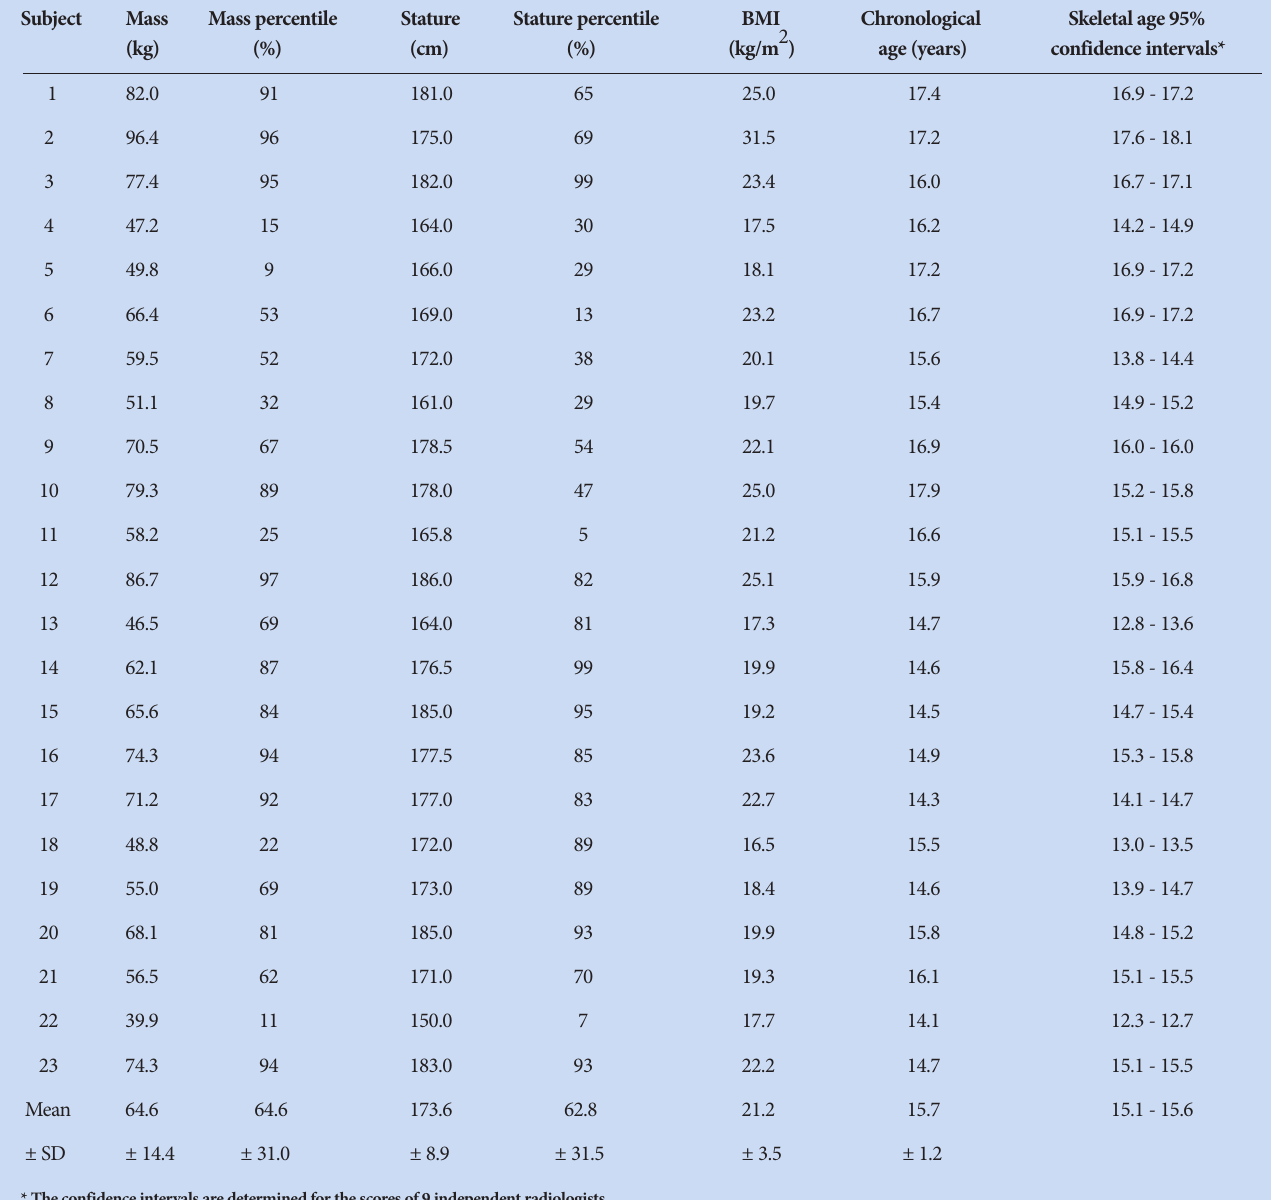
Table I. General characteristics of subjects ( N =